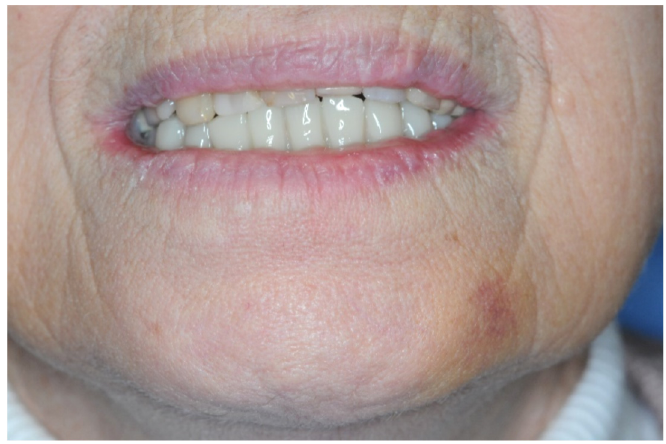
Figure 18. Details of the hematoma 3 days after surgery.